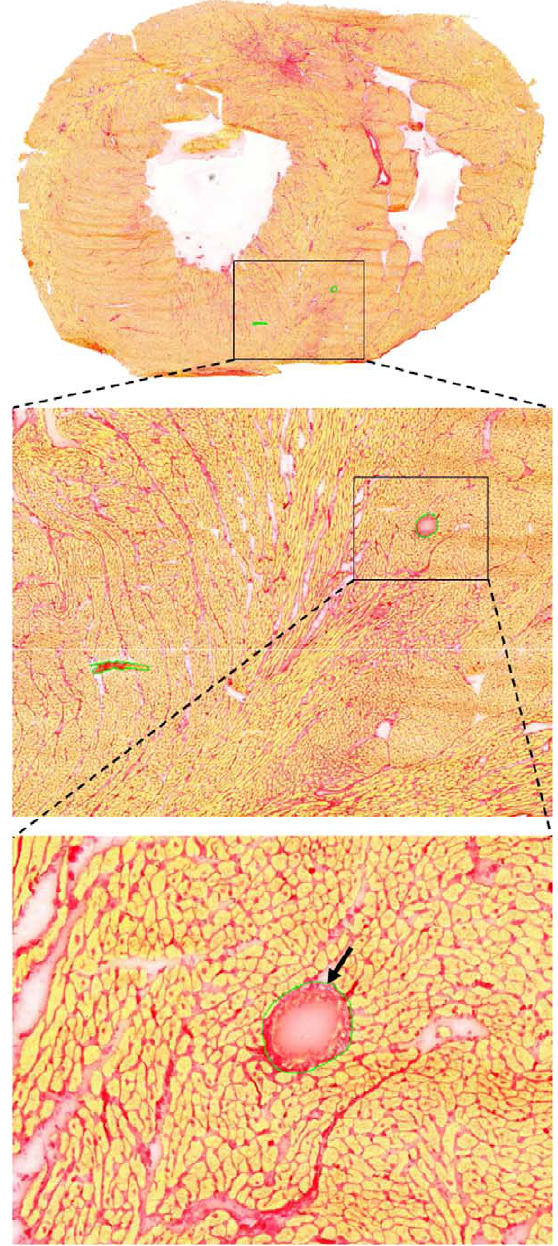
Fig. 1. The Mirax scan was used to scan entire sections of Picrosirius red stained myocardial. The Mirax viewer software allows the user to navigate through the section and zoom until the desired magni- fication used for analyses of fibrosis. If the user wishes to exclude areas, like staining artifacts or vessels, the user can apply annota- tions to the image by demarcating them in (in our study) green (ar- row). (The colors are visible in the online version of the article;